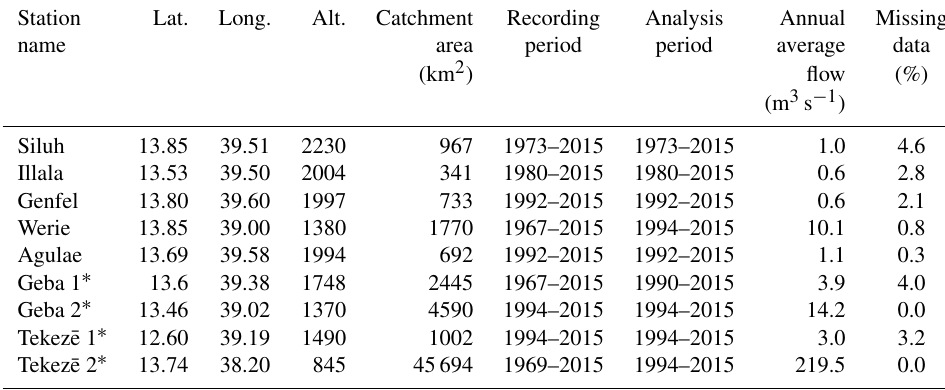
Table 3. General information on the hydrological flow monitoring stations. Station Lat. Long. Alt. Catchment Recording Analysis Annual Missing name area period